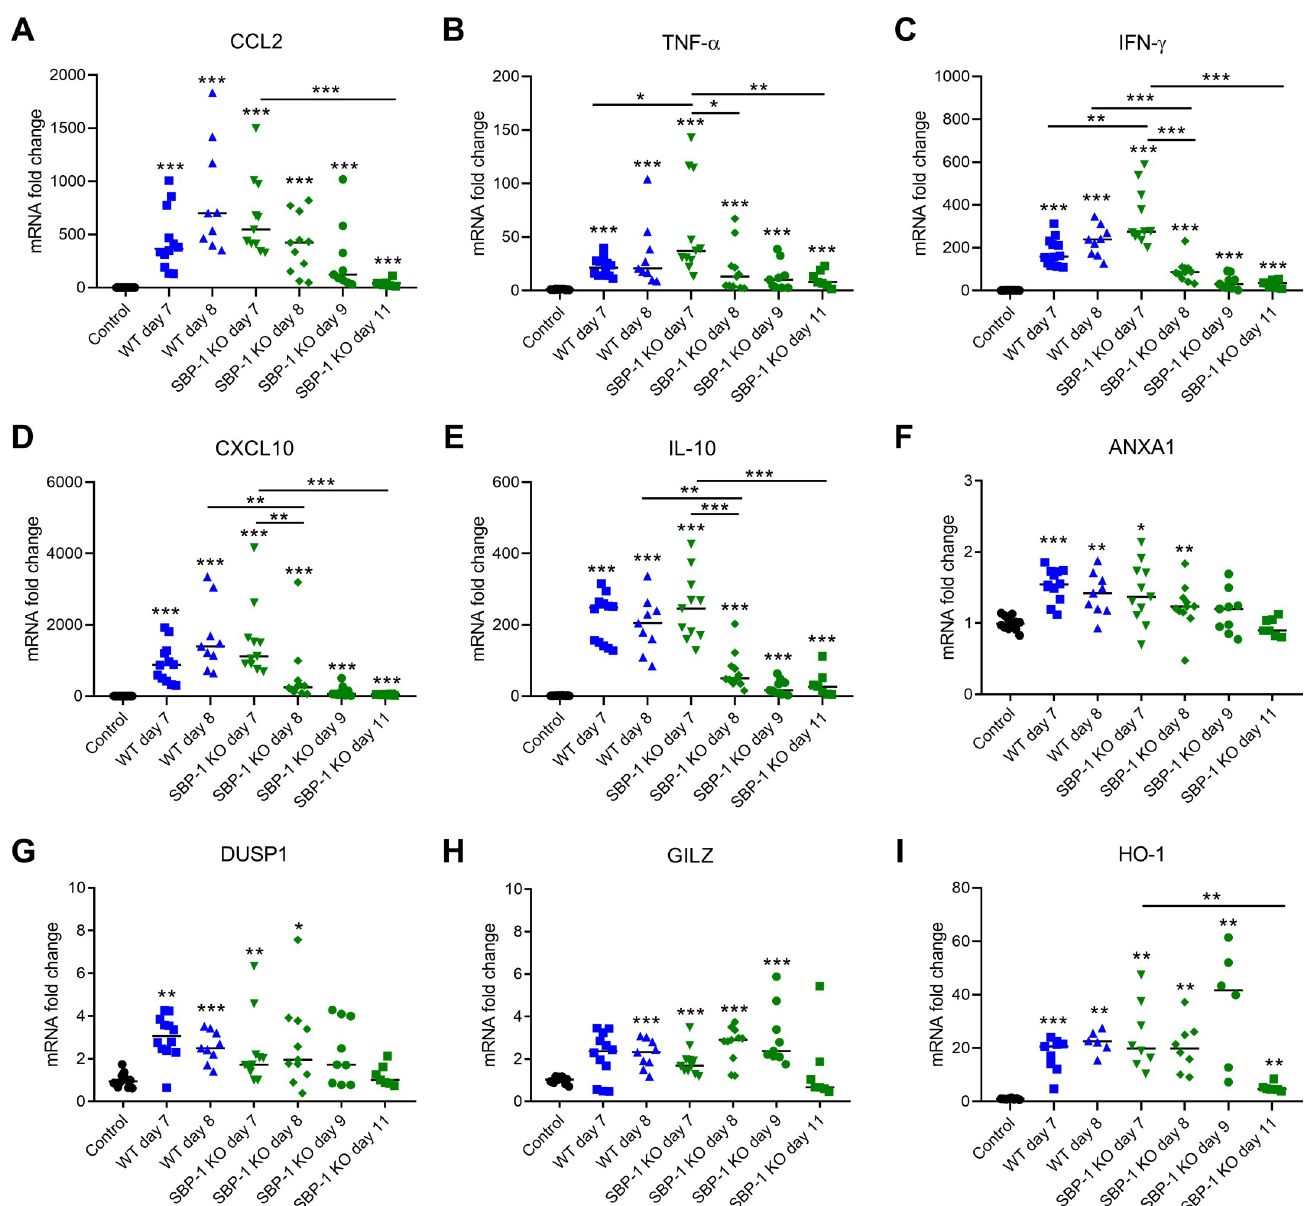
Fig 6. Resolution of inflammatory cytokine expression in lungs of SBP-1 KO infected mice. C57BL/6 mice were infected with WT and SBP-1 KO Pb NK65 parasites. Infected mice were euthanized and dissected at day 7 and 8 p.i. (WT and SBP-1 KO), day 9 and 11 p.i. (SBP-1 KO). Lungs were homogenized and mRNA levels of (A) CCL2, (B) TNF- α , (C) IFN- γ , (D) CXCL10, (E) IL-10, (F) ANXA1, (G) DUSP1, (H) GILZ, (I) HO-1 were measured by qRT-PCR. Asterisks above data points indicate significant differences compared to control mice, asterisks above a horizontal line show significant differences between infected groups. Panel A-H: data of three experiments, n = 7–12 per group, panel I: data of two experiments, n = 6–9 per group. Mann-Whitney U test with Holm-Bonferroni correction for multiple testing (number of tests = 11) was performed.